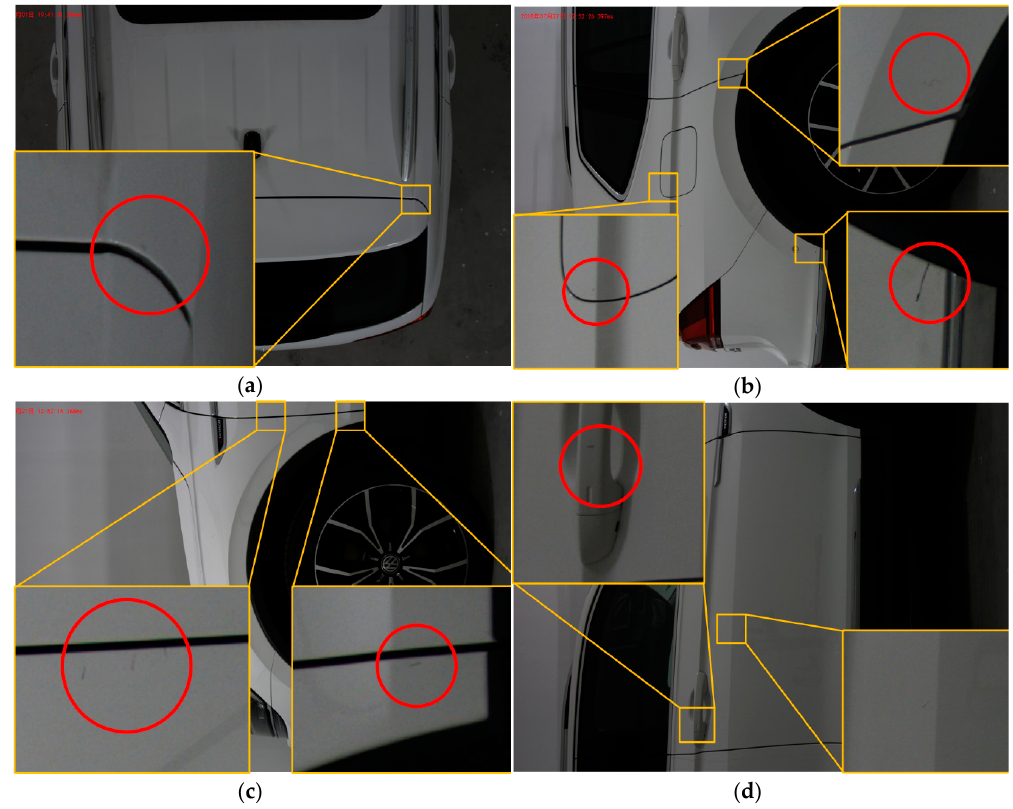
Figure 11. Set of detection examples showing the detection of defects on different position of car bodies ( a ) one defect near edge of body trunk cover on the roof of the car, ( b ) two defects near the edge of the fender surface ( c ) three defects, one on the fuel tank cover two near the edge of the fender surface ( d ) two defects, one on the handle, one near the style line.